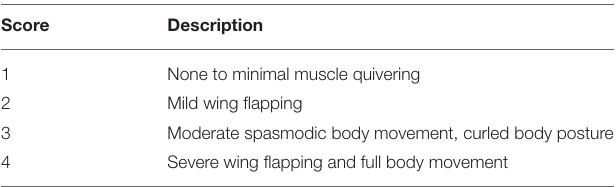
TABLE 1 | Scoring scheme for post mortem carcass activity in turkeys; adapted from McNeal et al. (5).